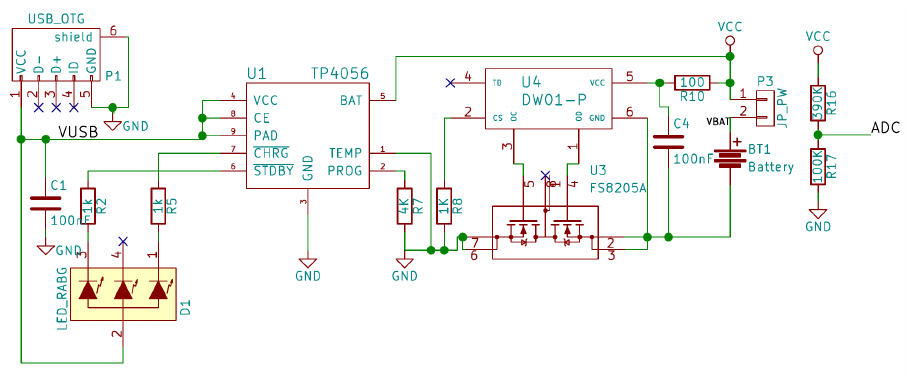
Figure 8. Schematic where the charging circuit of the battery that powers the design is shown.